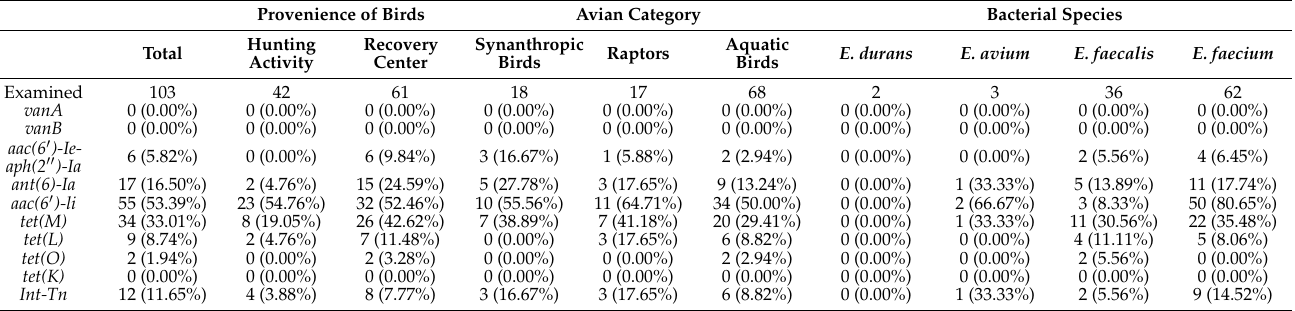
Table 3. Results of the molecular analyses in relation to the bacterial species, provenience, and category of